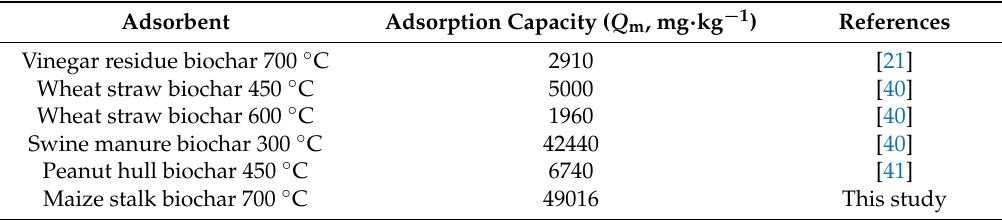
Table 4. Comparison adsorption capacity of maize stalk biochar for Cd with different